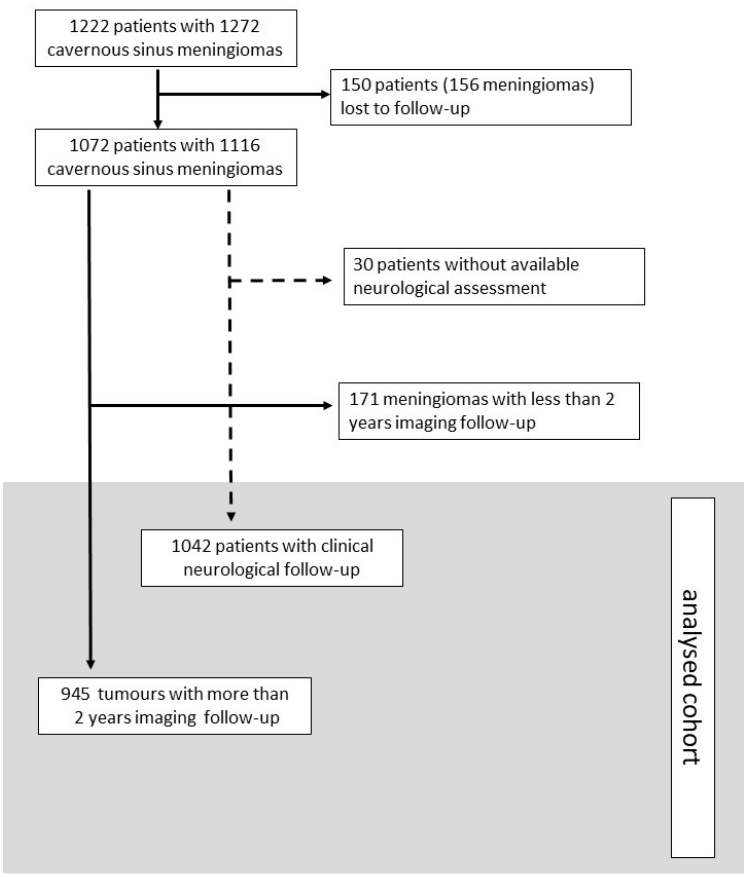
Figure 1. Flow chart of analysed cohort .